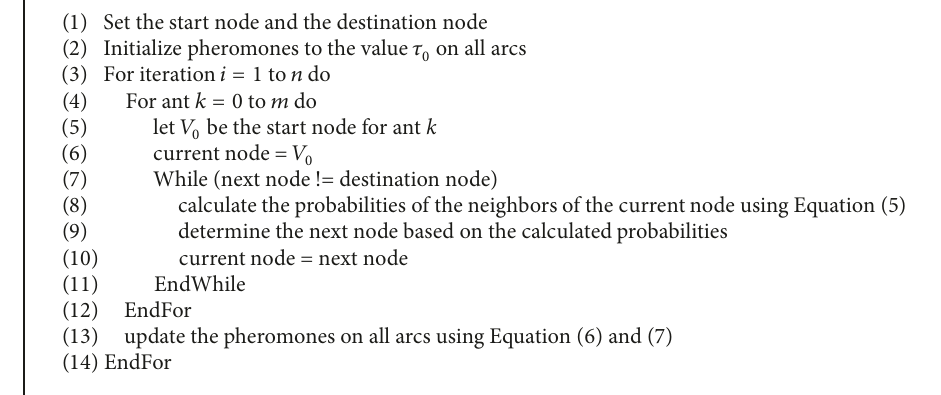
Algorithm 1: EV routing algorithm using